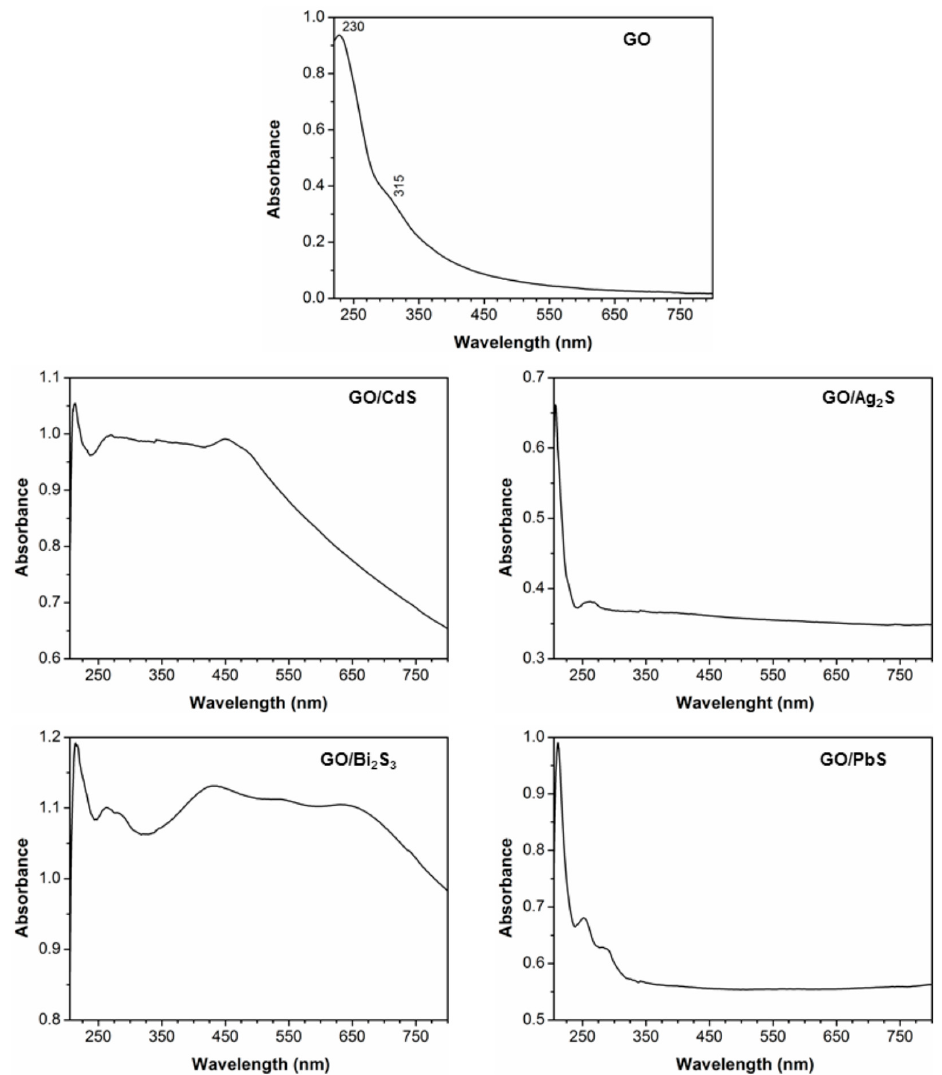
Figure 2. UV/Vis absorption spectra of ethanolic suspensions (0.05 mg/mL) of hybrid carbon nanostructures as indicated in the labels. For comparison, the UV/Vis spectrum of a graphene oxide suspension is also shown.